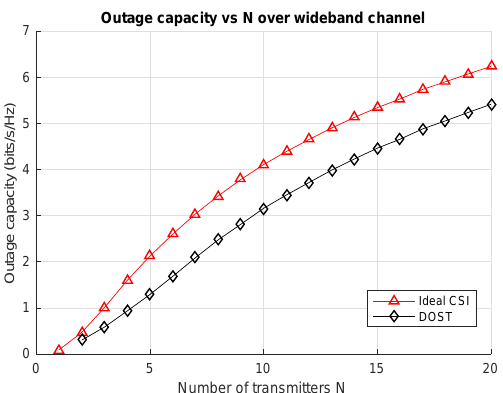
Figure 10. 1% outage rates (b/s/Hz) vs N for wideband channel at average SNR = − 5